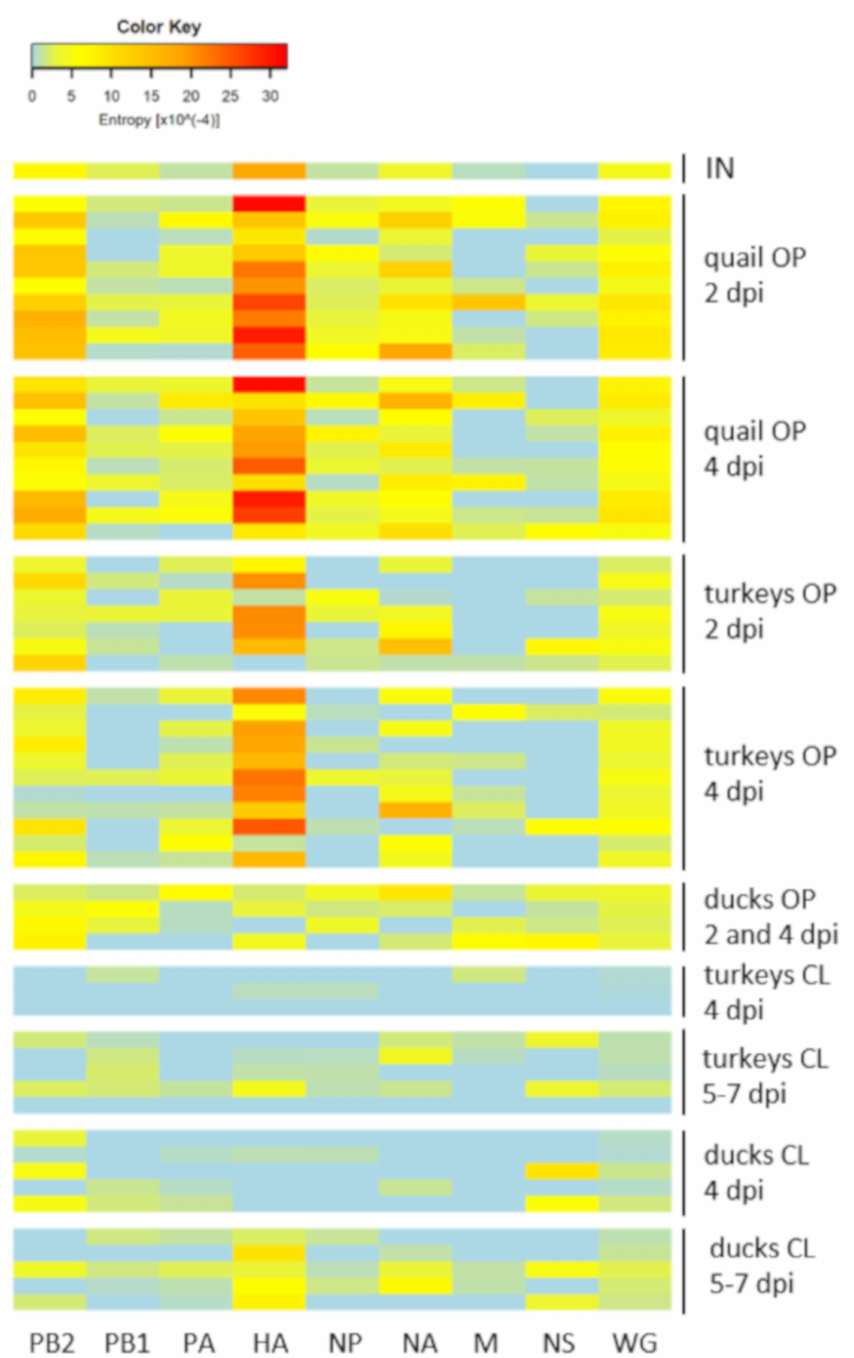
Figure 3. Heatmap of Shannon entropy for each genome segment and the whole viral genome (WG) calculated from the frequencies of variants present in the virus population in oropharyngeal and cloacal swabs collected from turkeys, quail and ducks infected with H9N2 LPAIV. Each row refers to individual sample. IN – inoculum, OP – oropharyngeal swab, CL – cloacal